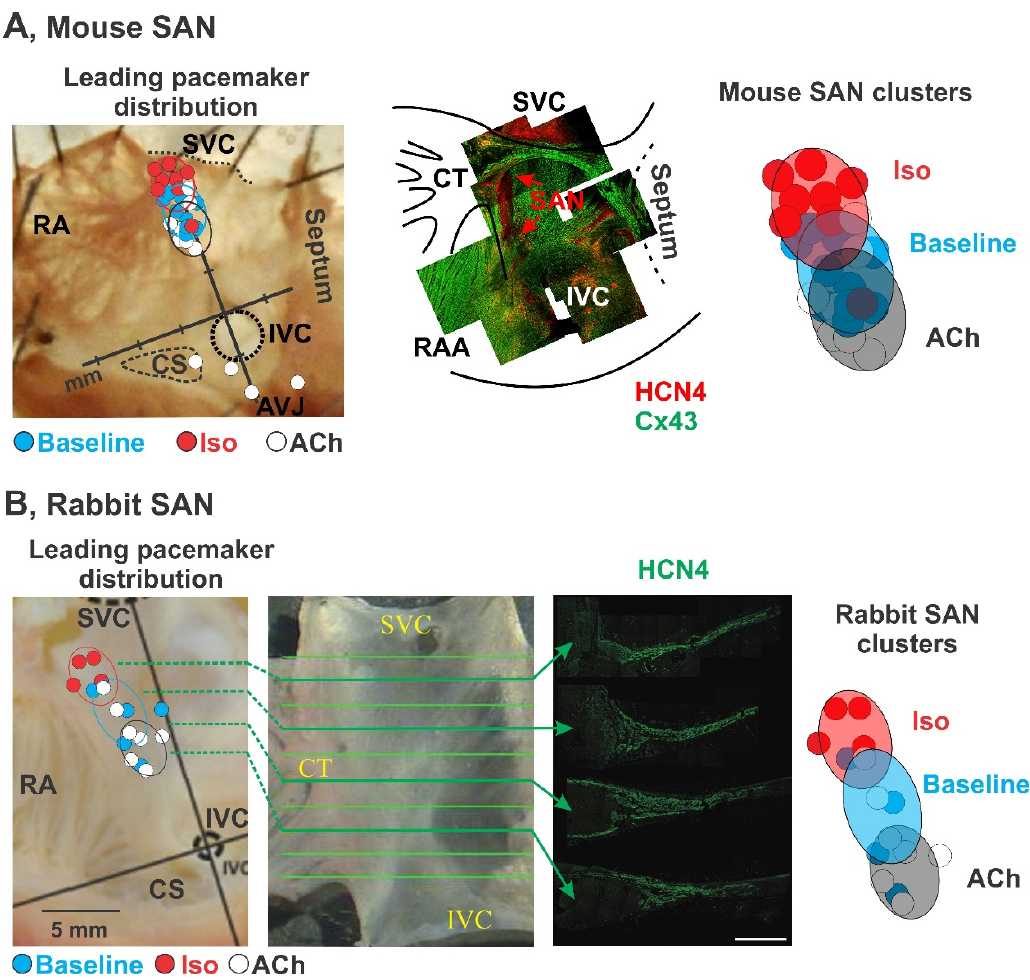
Figure 1. Pacemaker shift in mouse and rabbit SANs. Figures are modified from Glukhov [48,49] for mouse, and Lang [7], for rabbit. ( A ) Pacemaker shift in the mouse SAN under sympathetic (isoproterenol, or Iso; red dots) and parasympathetic (acetylcholine, or ACh; white dots) stimulations. Leading pacemakers under different conditions were visualized by optical mapping in isolated mouse right atrial preparations. SAN area was identified by connexin 43 (Cx43)-negative and HCN4-positive immunofluorescent staining. Iso shifted the leading pacemakers superiorly and ACh shifted them inferiorly within the anatomically and functionally defined SAN. ( B ) Pacemaker shift in rabbit SAN under sympathetic (Iso; red dots) and parasympathetic (ACh; white dots) stimulations. Leading pacemakers distributed within three distinct areas of the SAN, which is identified as HCN4-positive area. Similar to mouse, Iso and ACh shifted the leading pacemakers from the center of the rabbit SAN to superior and inferior intranodal pacemaker clusters, respectively.